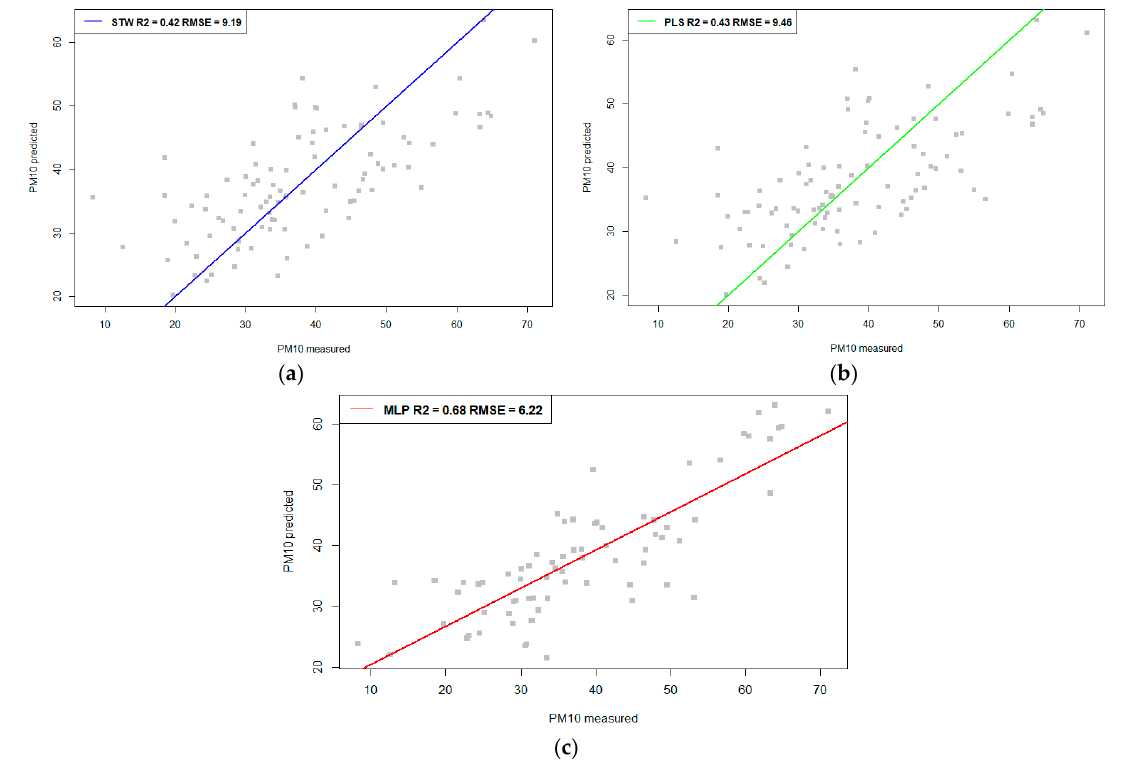
Figure 3. Comparison between R 2 and root mean square error (RMSE) in the model results for Landsat-8 data: ( a ) stepwise regression (STW); ( b ) partial least square (PLS); ( c ) MLP.